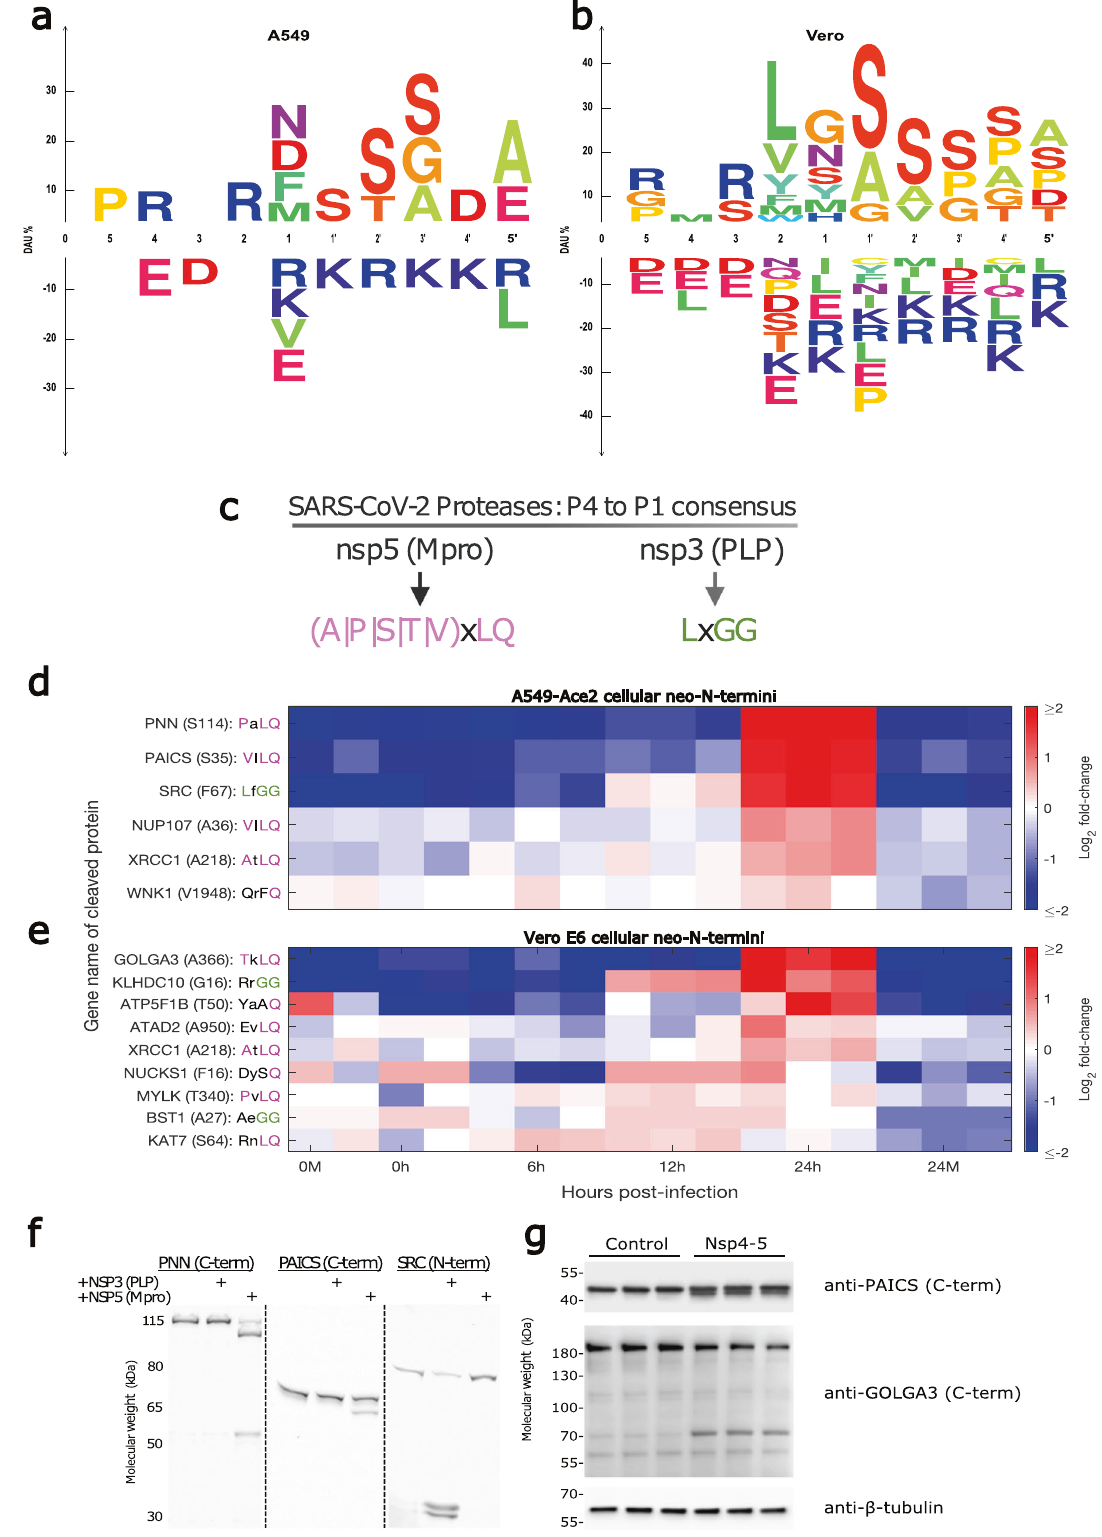
common themes included mitochondria, and the cytoskeleton/ cell adhesion. We then sought to identify neo-N-termini that could be targeted directly by the SARS-CoV-2 proteases, rather than host cell proteases. The consensus sequences for coronavirus proteases are conserved between coronaviruses, with PLP recognising a